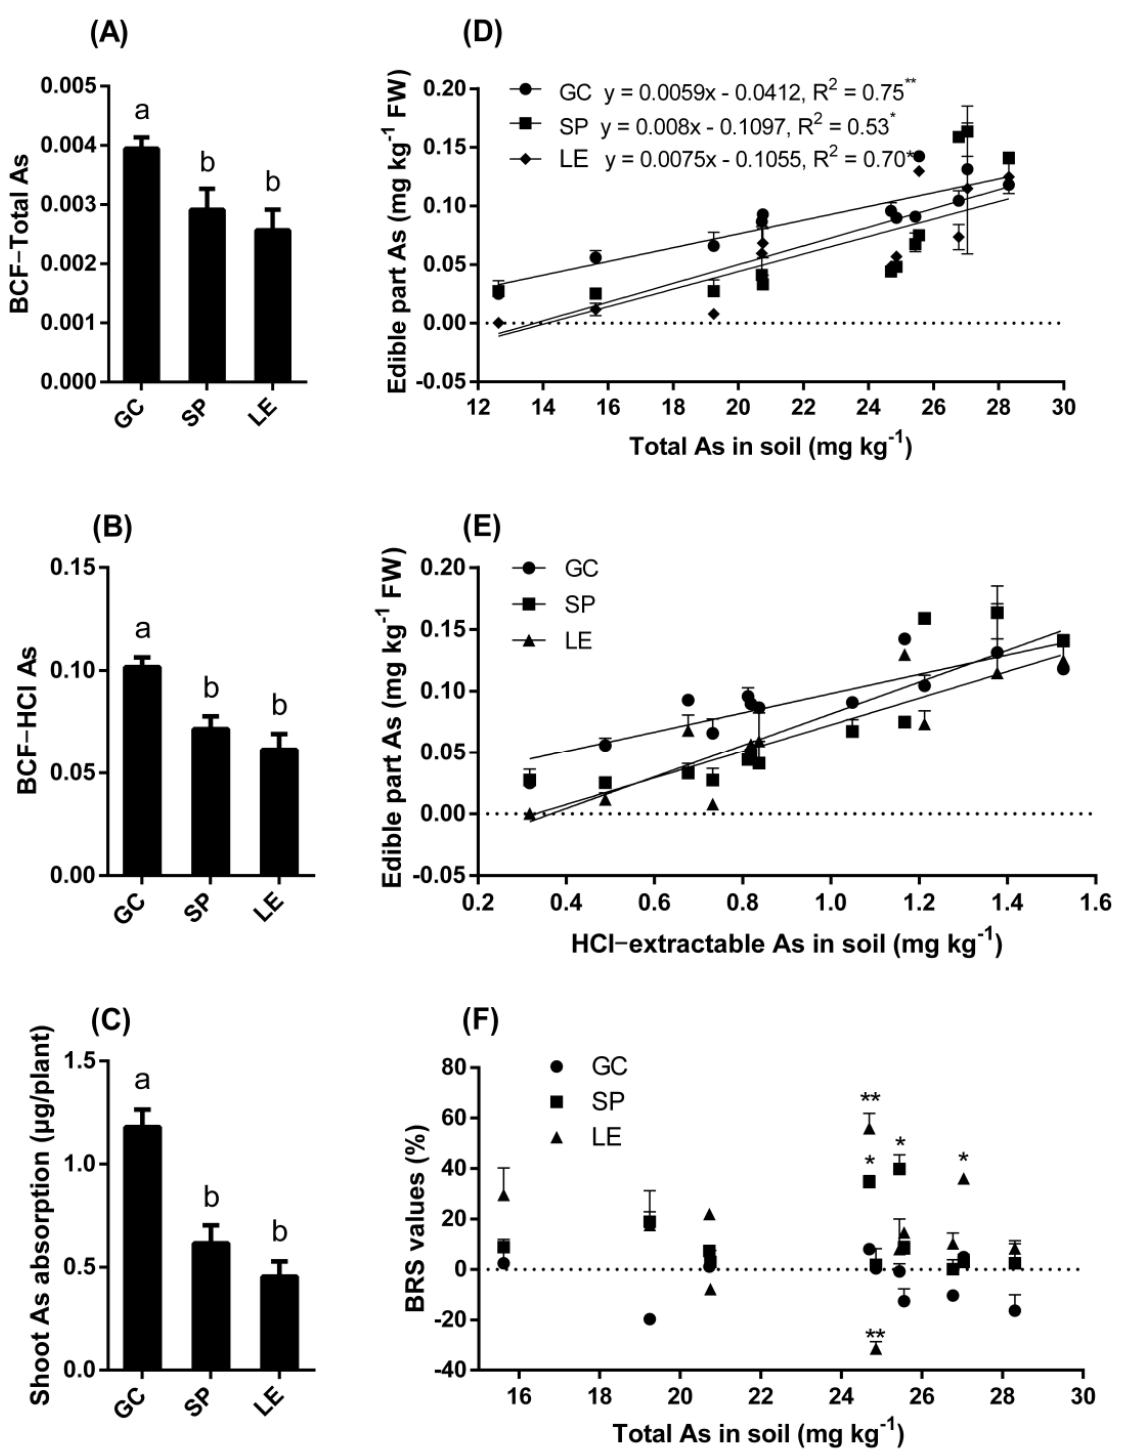
Figure 1. Bioconcentration factor ( A , B ), absorption ( C ), vegetable As concentration ( D , E ), and BRS values ( F ) in the soil test. Note: The different lowercase letters in the figure indicate significant differences between different vegetables (5% levels). The symbols * and ** indicate that the difference between values is significant at the respective 5% and 1% levels.